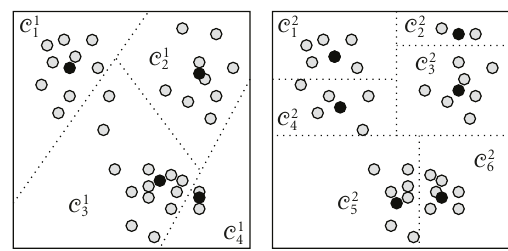
Figure 1: Two clustering results of the same data but using a di ff erent method.